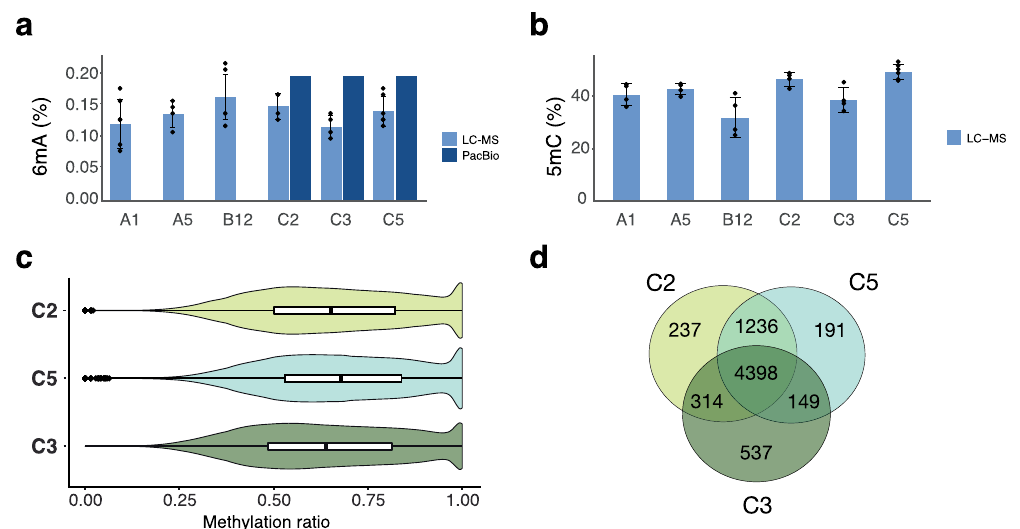
Fig. 2 Quanti fi cation of 6mA and 5mC in R. irregularis isolates. a Percentage of total methylated adenine (6mA) was detected by single-molecule DNA sequencing in three isolates (C2, C5, and C3) and validated by LC-MS in six isolates. The data are available in Supplementary data 3. b Percent of total methylated cytosine (5mC) detected by LC-MS in six isolates. The data are available in Supplementary data 3. c Violin plot (with boxplot inside) showing the distribution of the methylation ratio of R. irregularis isolate C2 ( n = 291654; minima:0, maxima:1, mean:0.6594, Q1:0.5020, Q3:0.8220), C5 ( n = 240110; minima:0, maxima:1, mean:0.6813, Q1:0.5300, Q3:0.8390) and C3 ( n = 263696; minima:0, maxima:1, mean:0.6465, Q1:0.4840, Q3:0.8140) suggesting that 6mA methylation in R. irregularis was highly heterogeneous. d Venn diagram representing numbers of common and unique genes harboring 6mA ApT motifs in isolates C2, C5, and C3. The majority of methylated genes were shared among isolates, yet considerable differences were observed among isolates and between clones C2 and